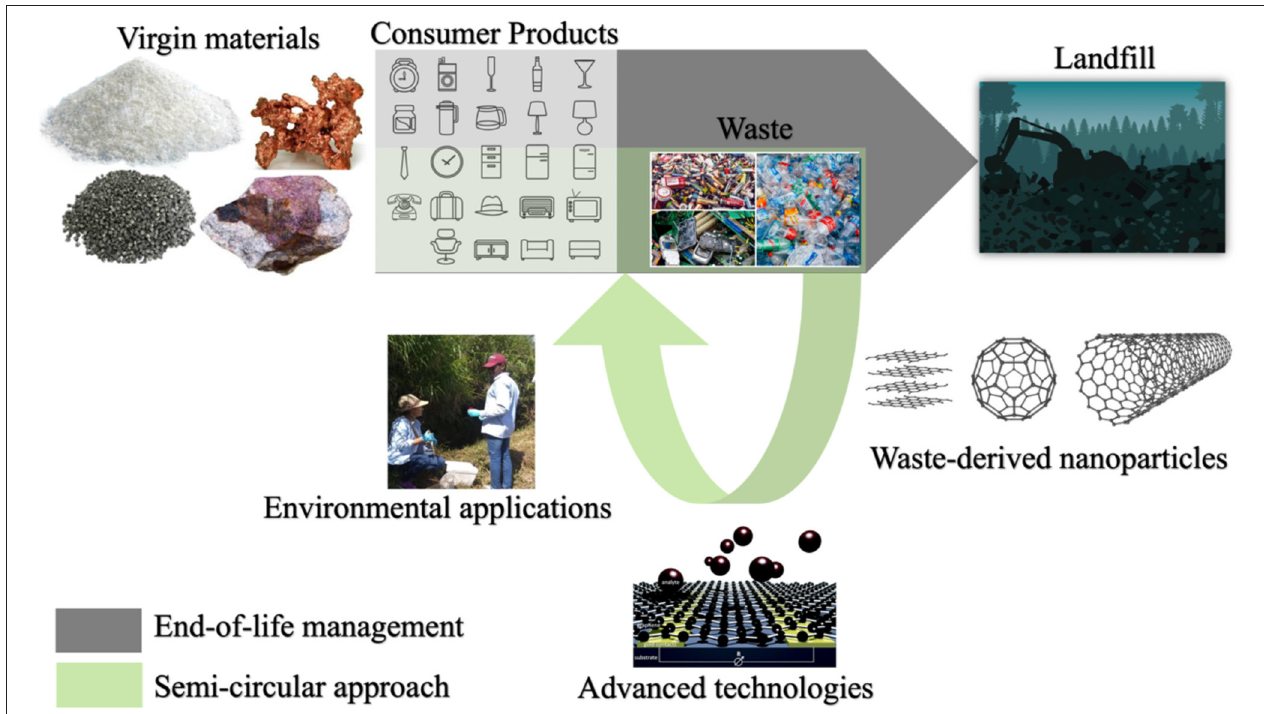
FIGURE 1 | Schematic representation of the concept discussed in the review article. industrial, electric, electronic and plastic wastes are suitable inputs for sustainable production of engineered nanoparticles, which can be further used in the development of advanced technologies for environmental applications. Thus, disrupting the linear end-of-life approach to waste management and increasing sustainability by closing the loop with the fabrication of value-added materials and technologies from waste. This schematic was created using public domain images obtained from a open source